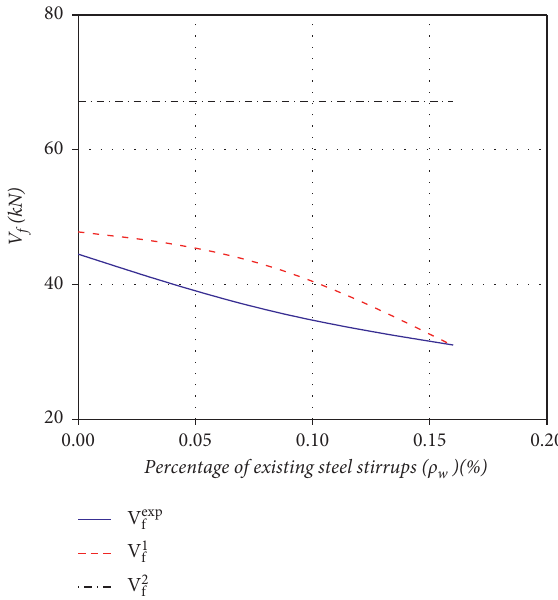
Figure 8: Effect of the percentage of existing steel stirrups on the contribution of the NSM FRP shear strengthening technique (the experimental FRP contribution gained from